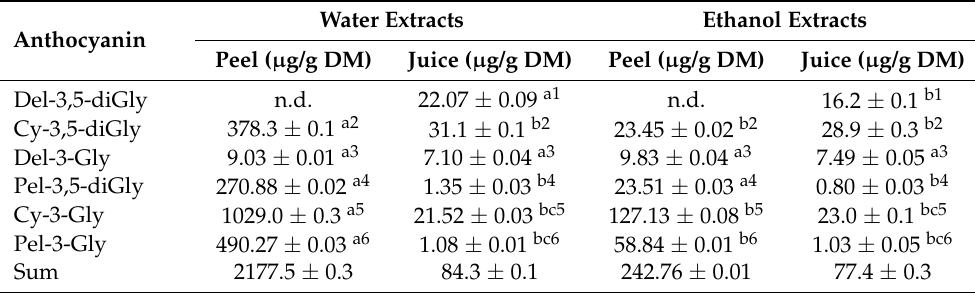
Table 7. Individual anthocyanins content in peel and juice pomegranate extracts determined with HPLC. Water Extracts Ethanol Extracts Anthocyanin Peel ( µ g/g DM) Juice ( µ g/g DM) Peel ( µ g/g DM) Juice ( µ g/g DM) Del-3,5-diGly n.d. 22.07 ± 0.09 a1 n.d. 16.2 ± 0.1 b1 Cy-3,5-diGly 378.3 ± 0.1 a2 31.1 ± 0.1 b2 23.45 ± 0.02 b2 28.9 ± 0.3 b2 Del-3-Gly 9.03 ± 0.01 a3 7.10 ± 0.04